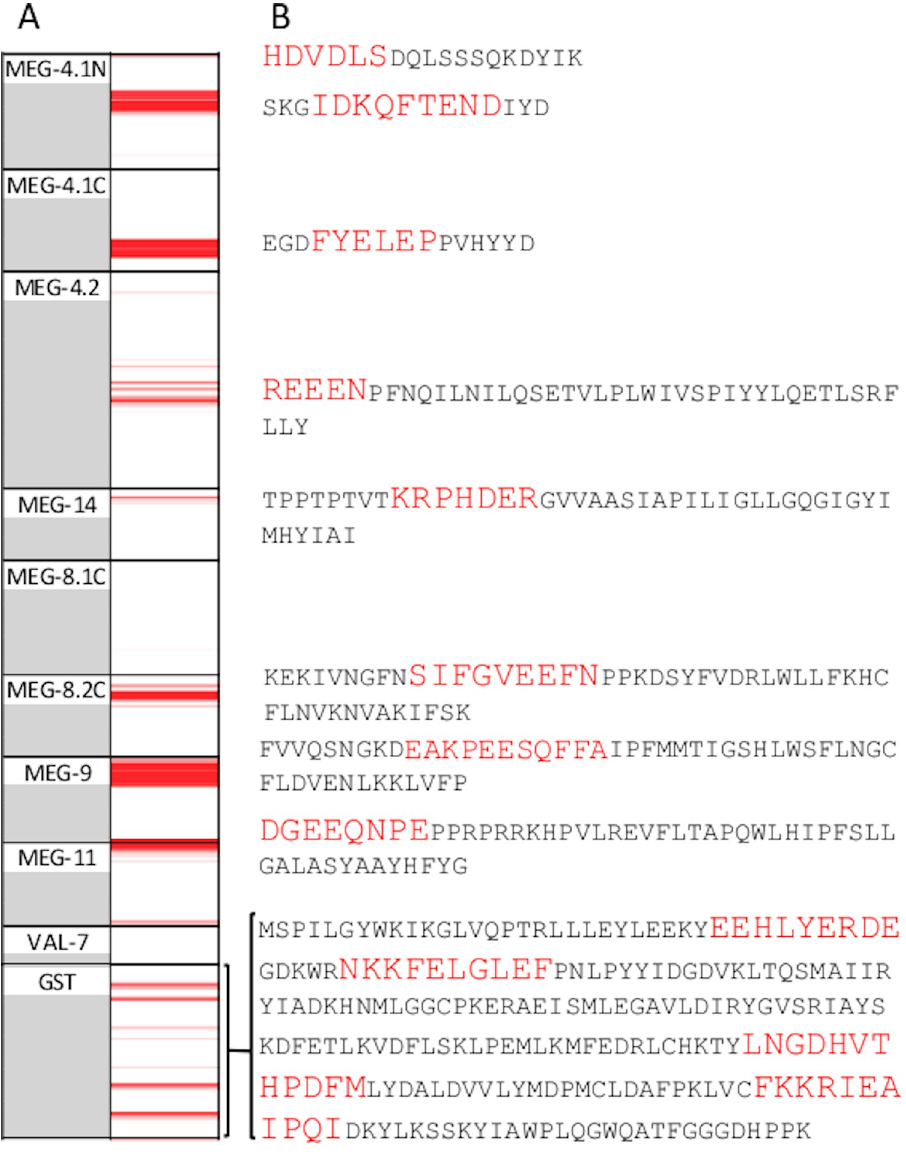
Fig 2. Heat map and peptides used for vaccination. Positive control A, Column 1 shows positions of 15mer overlapping peptides for the S . japonicum proteins printed on Array 1b. Column 2 shows the heat map of serum reactivity at 1:1000 dilution for rat and 1:100 for mouse, on a scale 1000–25000. B, Synthetic peptides used to immunise rats, and full length sequence of Sj26GST. Amino acids highlighted in red are the putative epitopes detected by the respective sera. No serum was available against